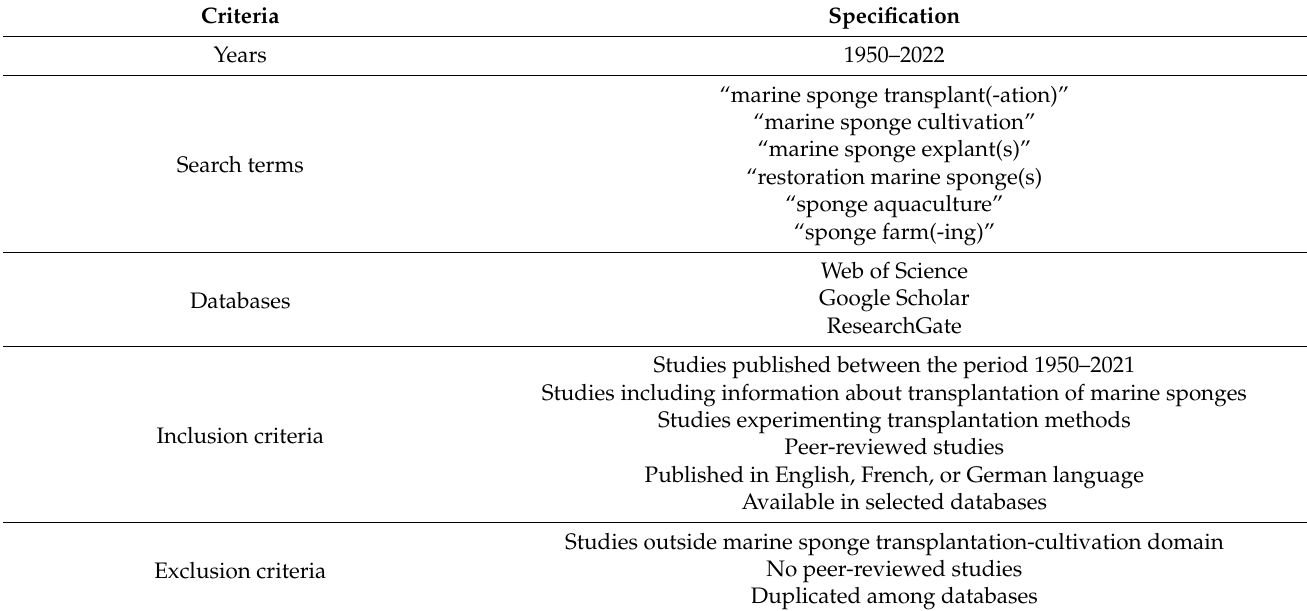
Table 1. Search procedure and inclusion-exclusion